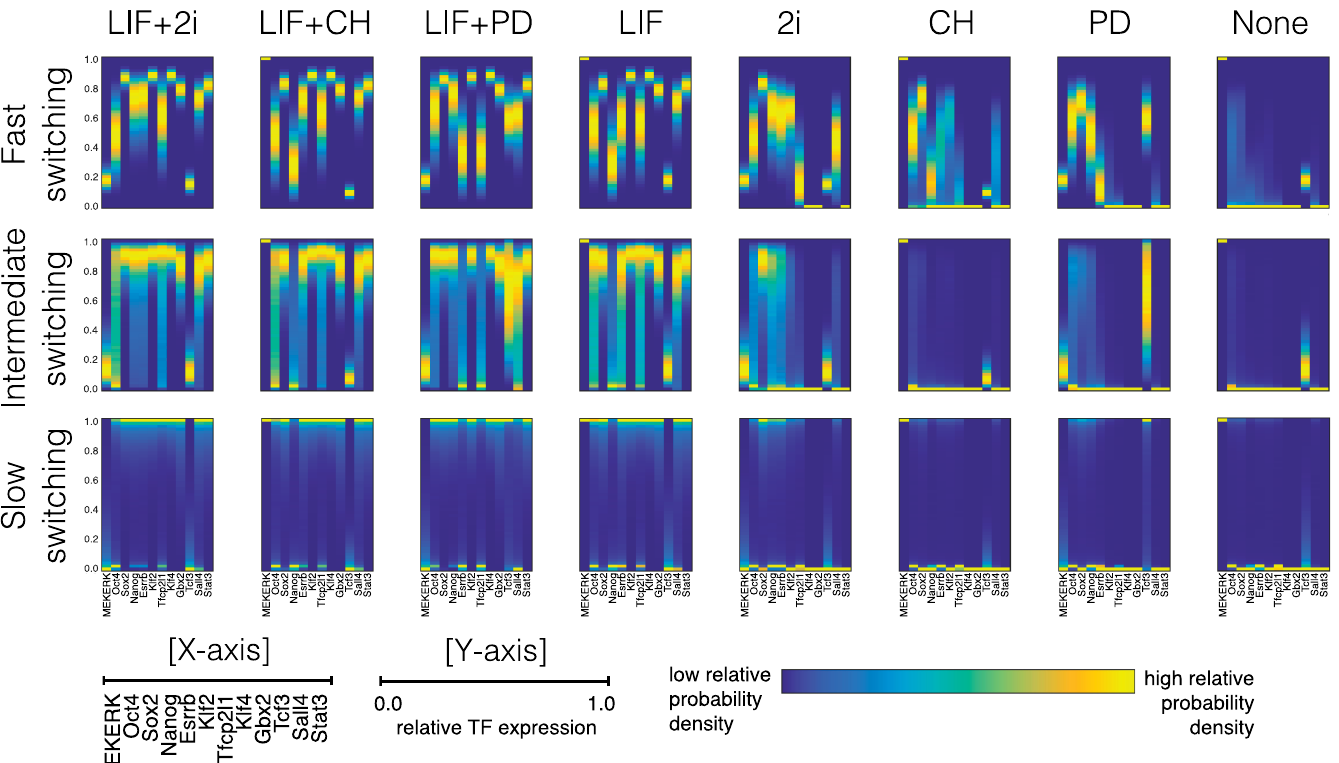
Fig 3. Gene expression profiles of pluripotency factors predicted by PDMP simulations. Each column corresponds to different external inputs, and each row corresponds to regimes of slow, intermediate and fast gene switching. More than 10 5 sample paths were used for generating each condition.